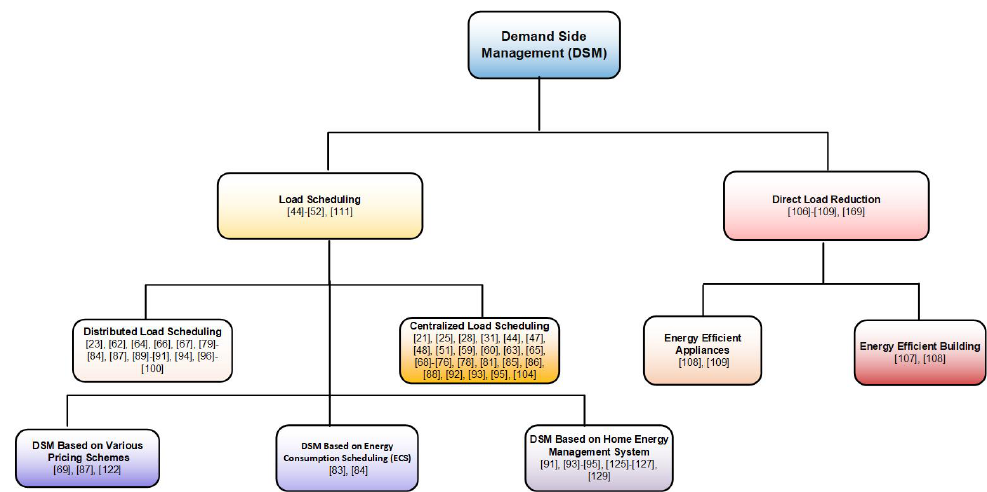
Figure 4. Classification of